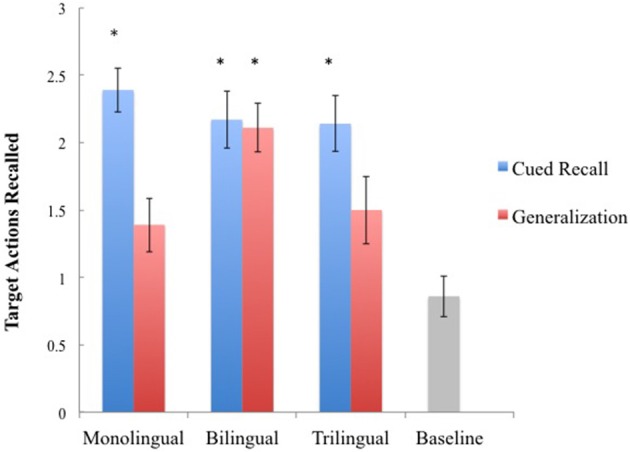
Mean imitation scores across language groups with error bars indicating standard error of the mean. An asterisk indicates that performance significantly exceeds that of the baseline control group.